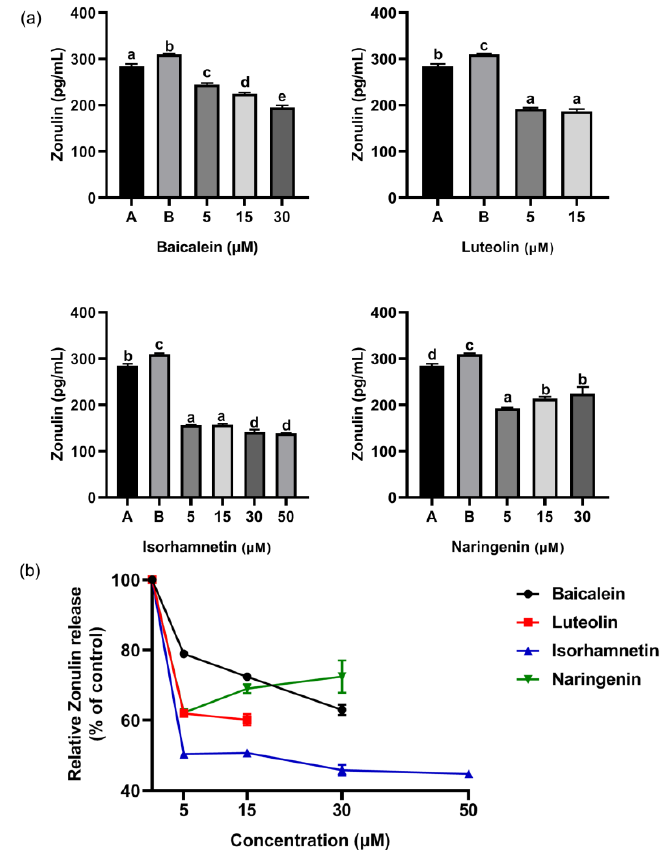
Figure 12. ( a ) Effect of four flavonoids on the release of Zonulin from Caco-2 cells induced by ω -5 gliadin-derived peptide P4. A (blank group): only Caco-2 cells; B (control group): 150 µ g/mL ω -5 gliadin-derived peptide P4+Caco-2 cells; note: different letters indicate significant differences between groups ( p < 0.05); ( b ) dose-effect relationship of four flavonoids of inhibition zonulin release.